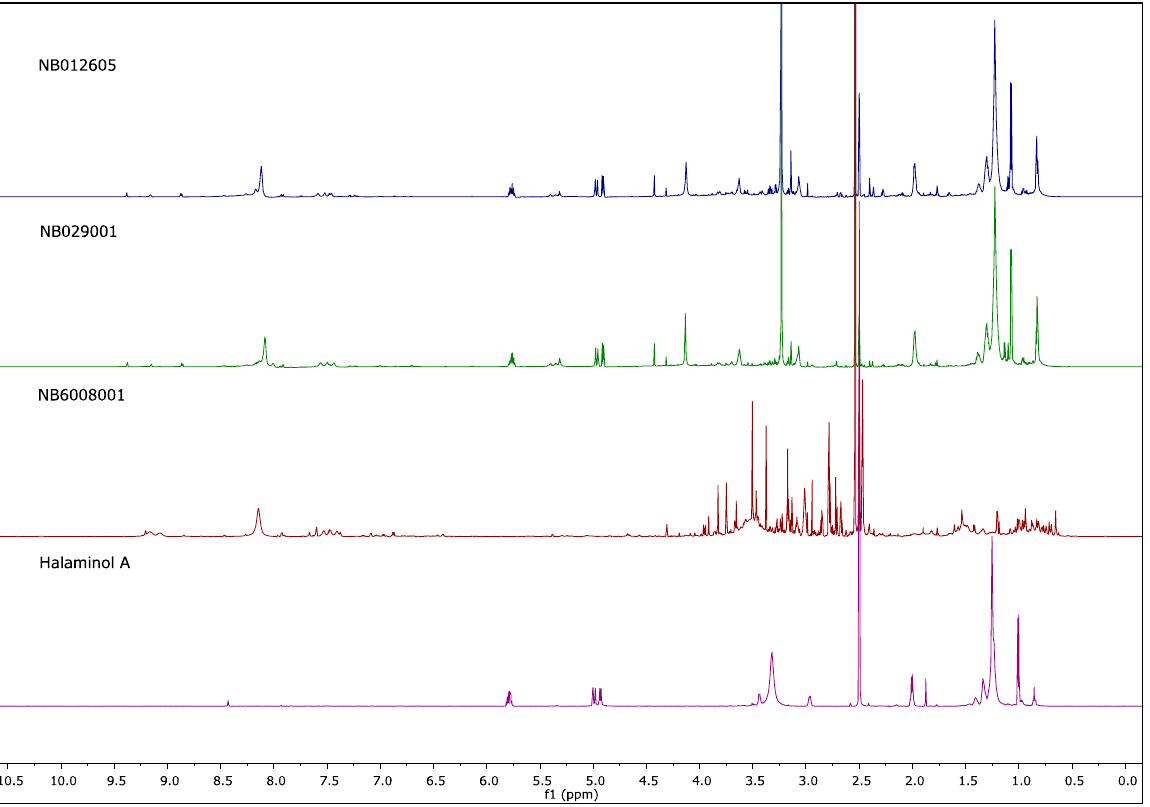
Figure 3. 1 H NMR (800 MHz) spectra of Haliclona extracts and halaminol A in DMSO- d 6 . An example of the dereplication of three extracts (NB012605, NB029001 and NB6008001; Table 1) from species of Haliclona.